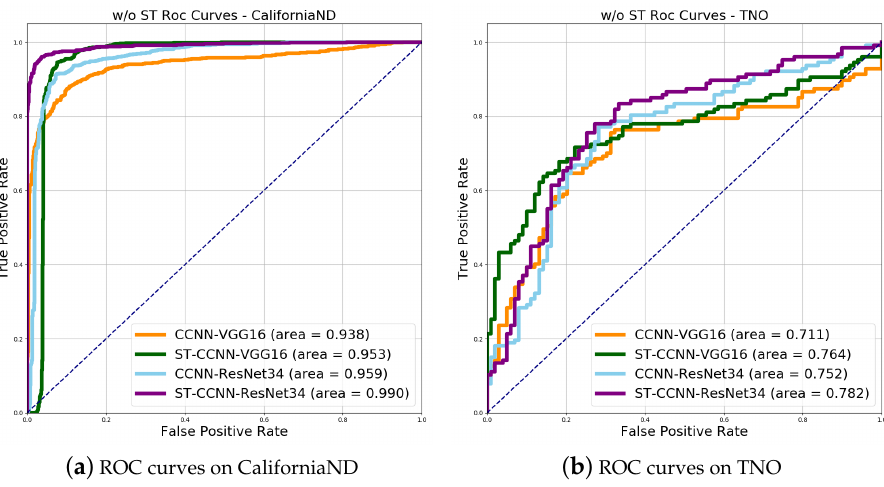
Figure 8. Illustration of ROC curves of networks with/without ST modules on single-modality and cross-modality. In both scenarios, ST-CCNN-based networks perform better than networks without ST